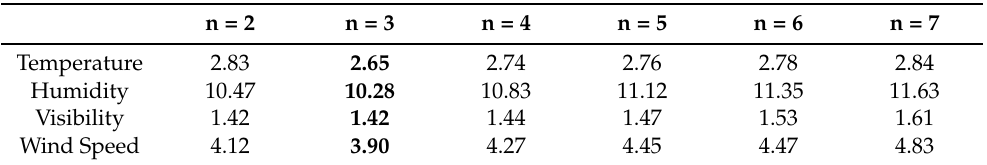
Table 2. Root mean square errors when different lengths of image sequences were used, based on the DHL-LSTM model. n = 2